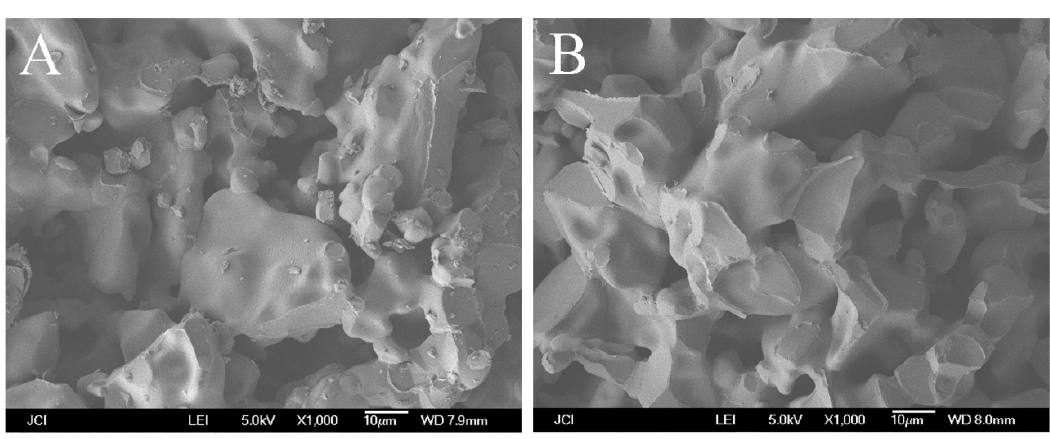
Figure 5. SEM images of the cross-section of supports with 0.6 wt.% of TiO 2 added by ( A ) in-situ precipitation method and ( B ) in-situ hydrolysis method.